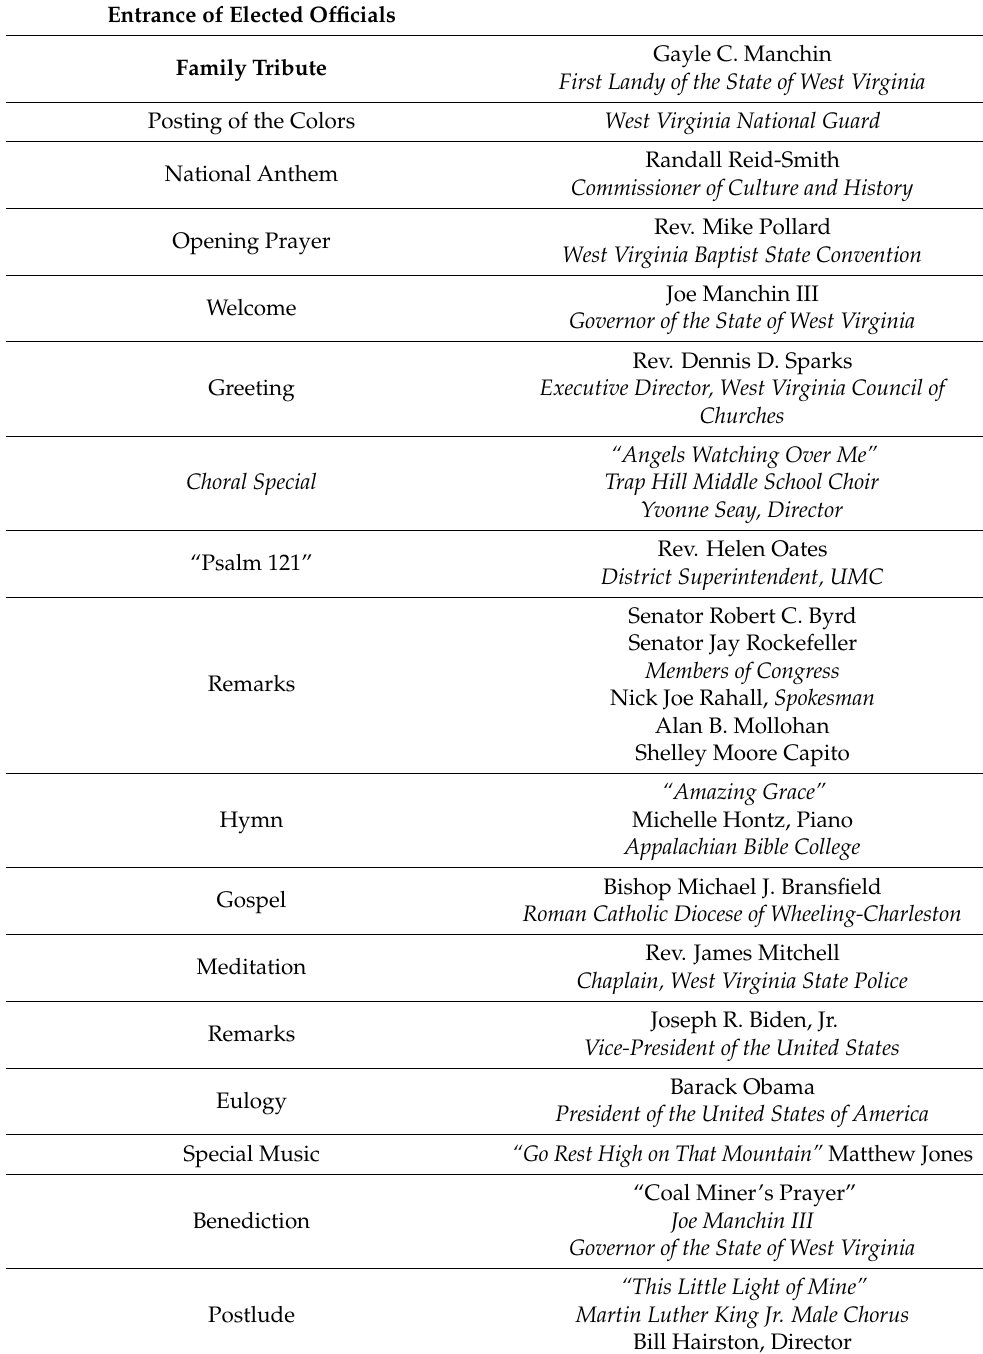
Table 1. A Memorial Service of Hope and